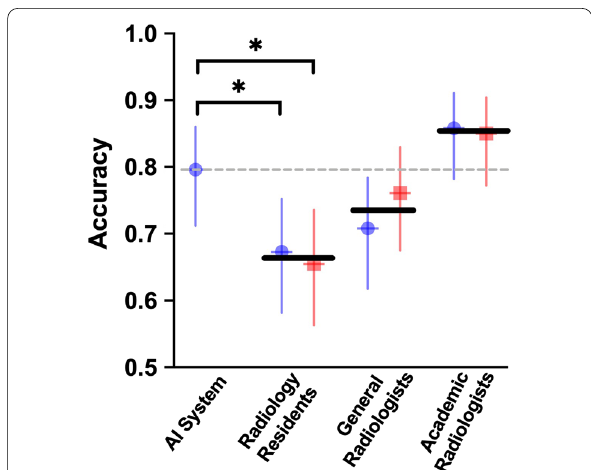
Fig. 3 Performance of the model compared to that of radiologists with various levels of specialisation. Performance is measured as accuracy. Each point represents a single radiologist, and the horizontal line represents the mean across each radiologist category. The horizontal dashed line is the performance of the model. Error bars represent 95% binomial probability CIs. *There was a significant difference in performance between the model and two types of residents ( p < 0.05)